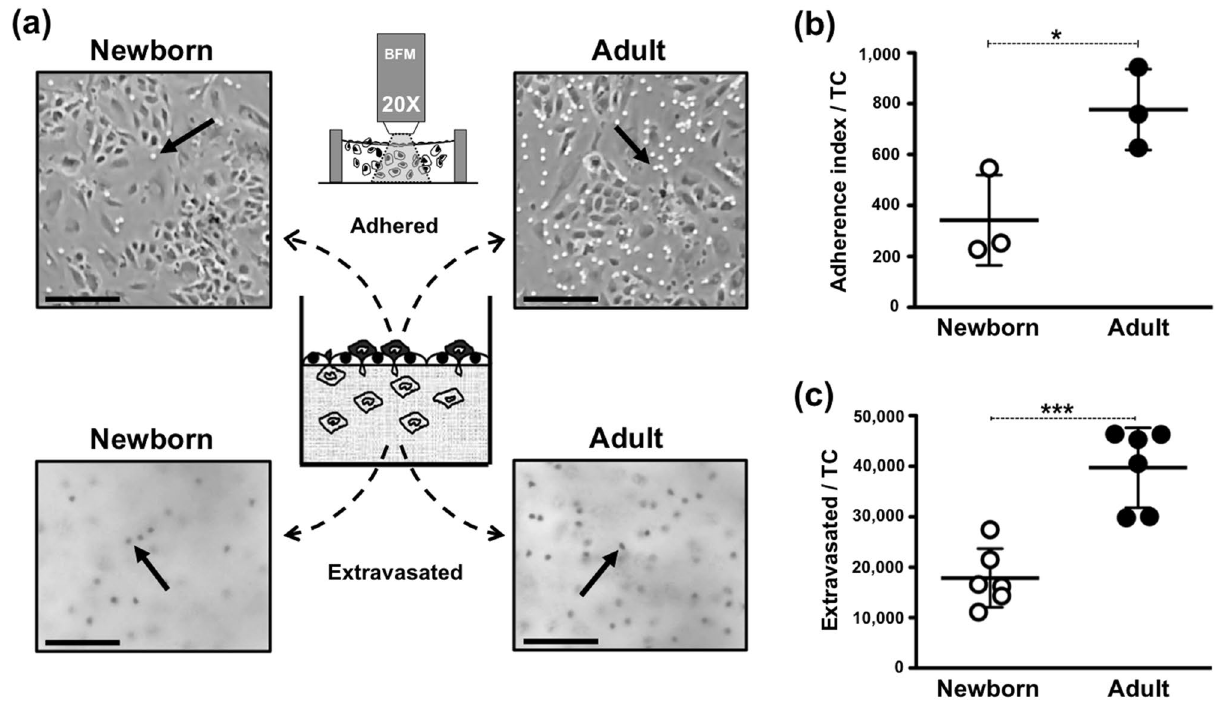
each confluent TC well to enable autonomous extravasation under corresponding 100% autologous untreated plasma for 1.5 h at 37 °C/5%CO 2 , as described in methods. ( a ) Newborn and adult monocytes adhered to the endothelium (bright dots indicated by arrows) and extravasated (dark dots indicated by arrows) after removal of non-migrated cells from the top of TCs (representative images taken at surface level and at ~ 80 mm